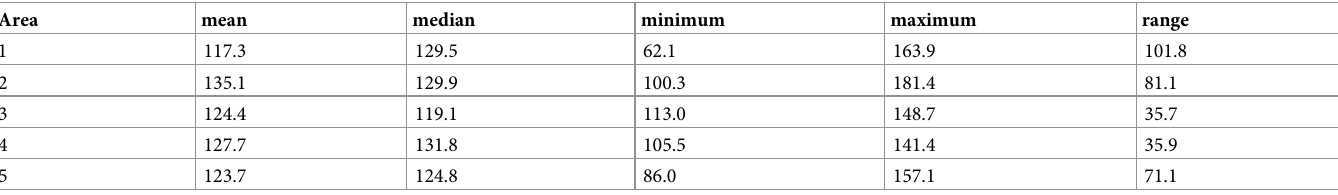
Table 3. Depth (m) of deployments in each sampling area along the designated